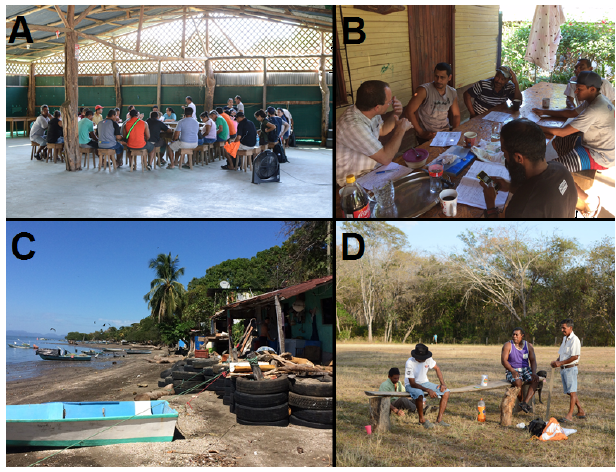
Fig. 3 . (A) Fishing association meeting at the Paquera-Tambor responsible fishing area (AMPR). (B) Trial deliberation and iterative feedback on the image-based framework with fishers and our research team in the Costa de Pajaros AMPR (Step 6 in Table 2). (C) Beach with small-scale fishing boats in Costa de Pajaros, a familiar setting throughout the Gulf of Nicoya. (D) Fishers deliberating in our field